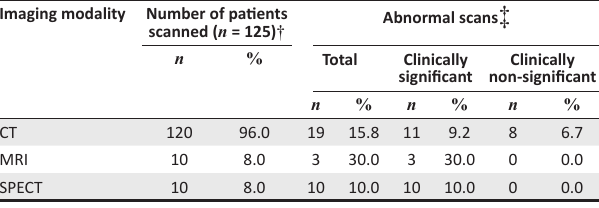
TABLE 2: Neuroimaging modalities and detected abnormalities. Imaging modality Number of patients scanned ( n = 125) †